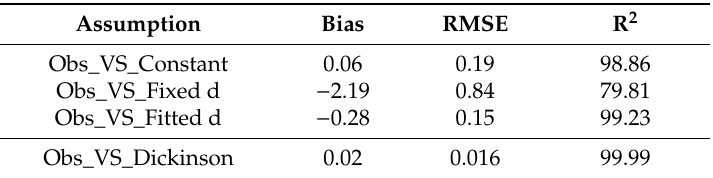
Table 2. The overall statistical of the comparison between the observed daily mean albedo and estimation under four assumption ( × 10 − 2